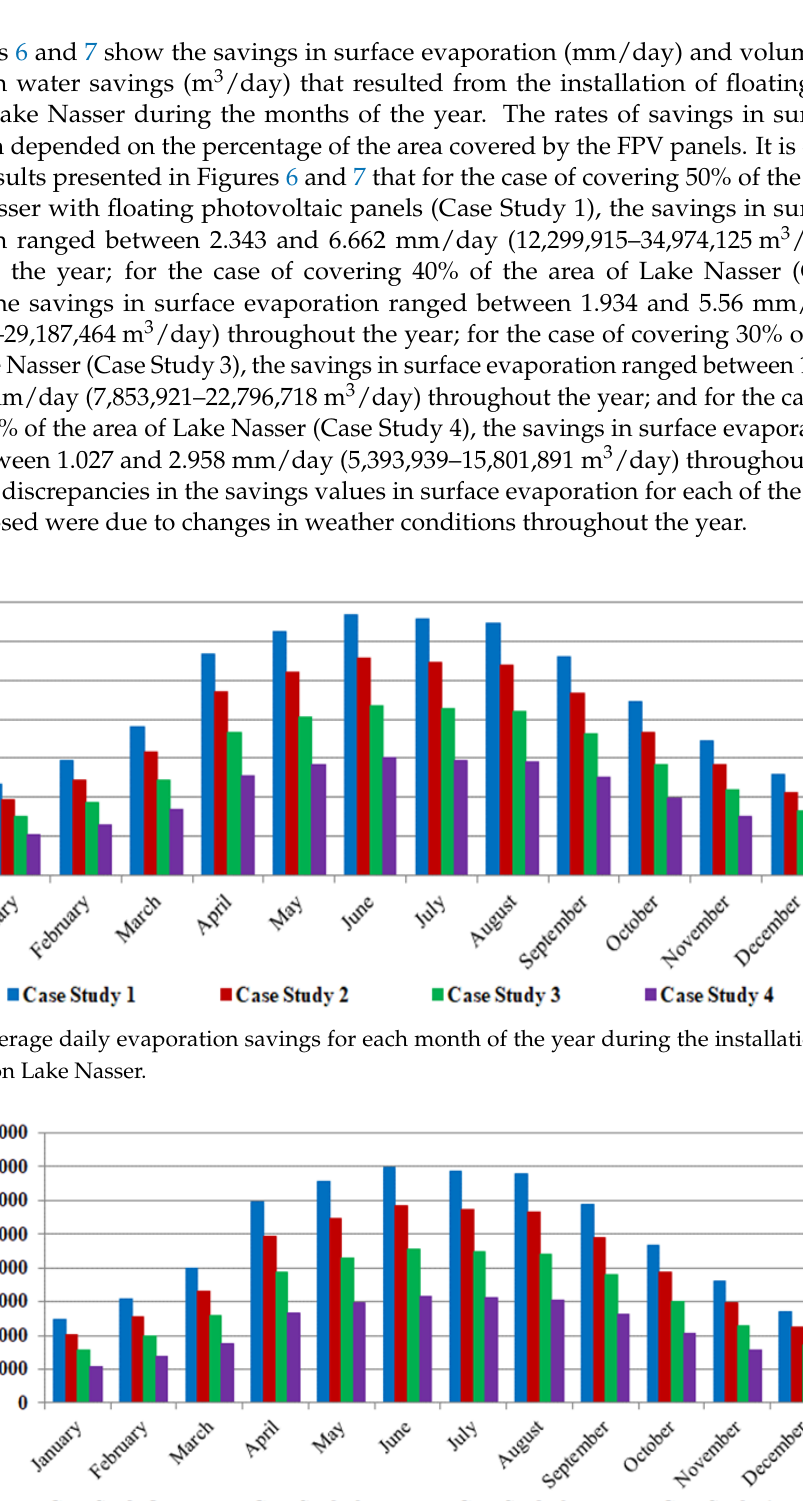
Figure 5. Average daily evaporation for each month throughout the year for the cases with and without FPV panels.